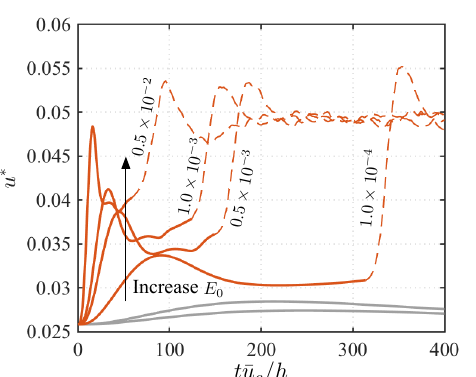
Figure 11. Time evolution of friction velocity u ∗ of case ( α , β ) = ( 0,2 ) initialized by different amplitudes of optimal disturbance E 0 : Red lines represent transition cases, and grey lines denote that the flow remains laminar. Dashed line indicates that the flow is in turbulent